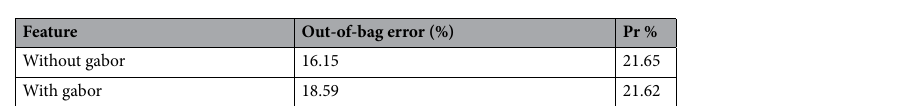
Figure 6. Classification procedure. Schematic flow chart illustrating how the Gabor and hierarchal features were included within the classification of the super and sub-objects. OOB classification error included in parenthesis.